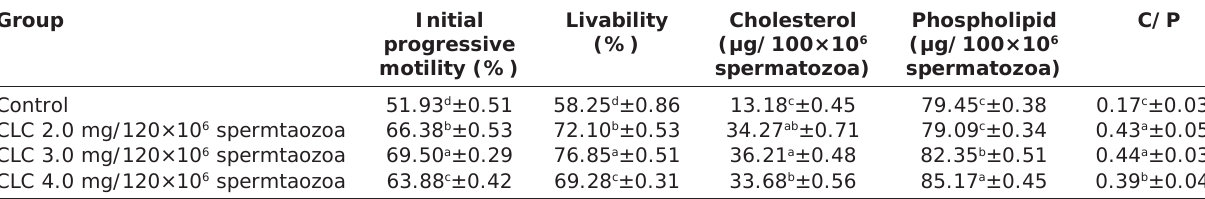
a, b, c, d Means with dissimilar superscript in a column differ significantly (p<0.01). SE=Standard